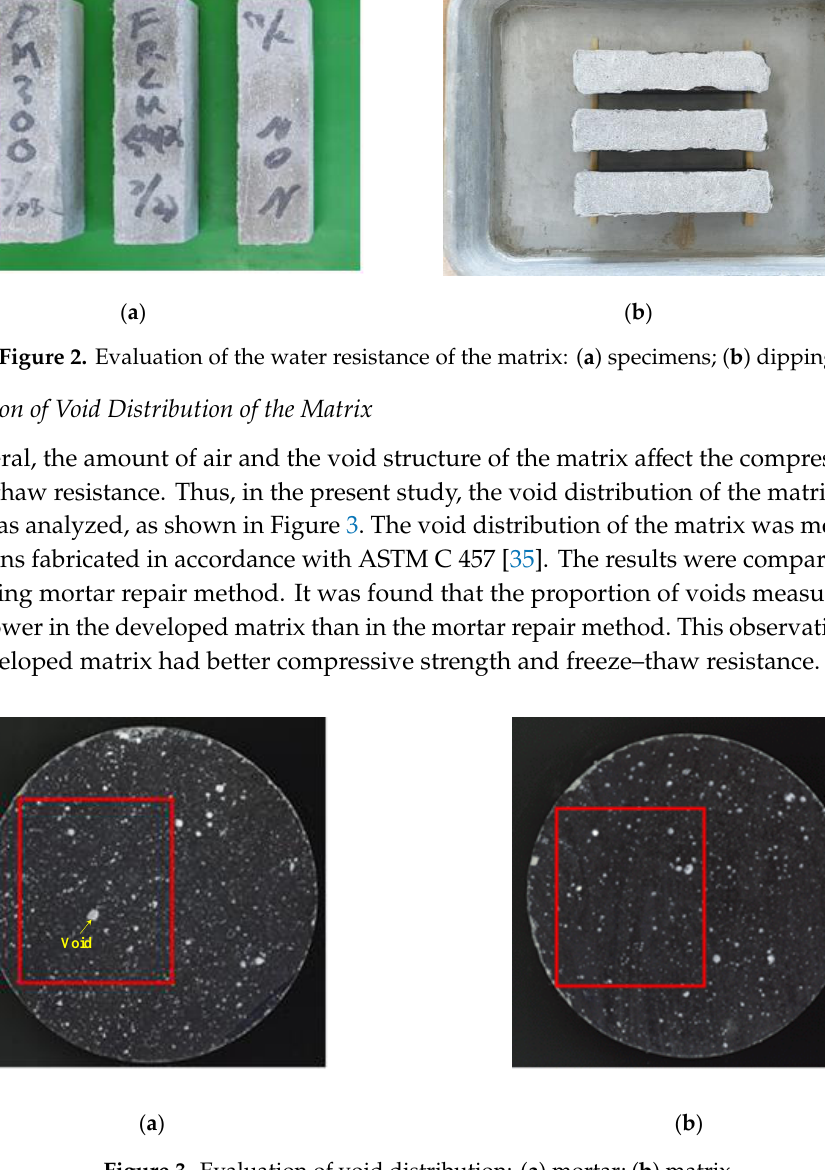
Figure 2. Evaluation of the water resistance of the matrix: ( a ) specimens; ( b ) dipping Table 4. Water resistance results.